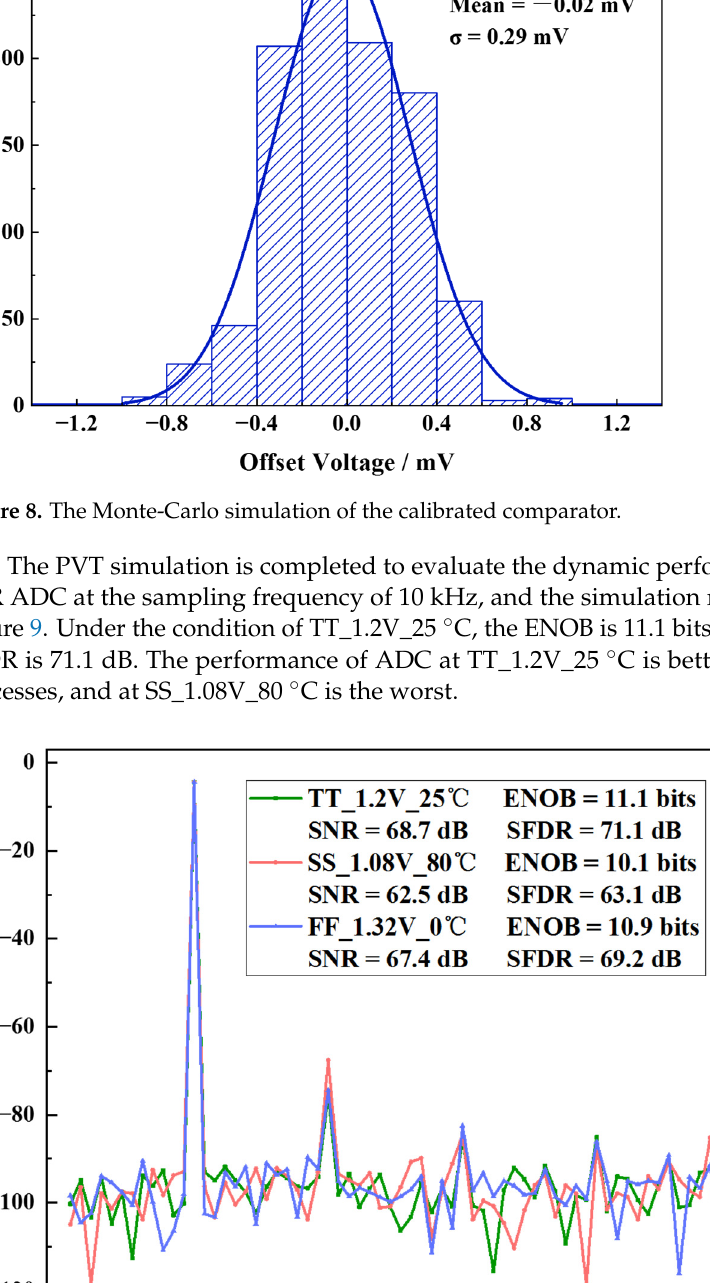
Figure 9. The PVT simulation of the SAR ADC.